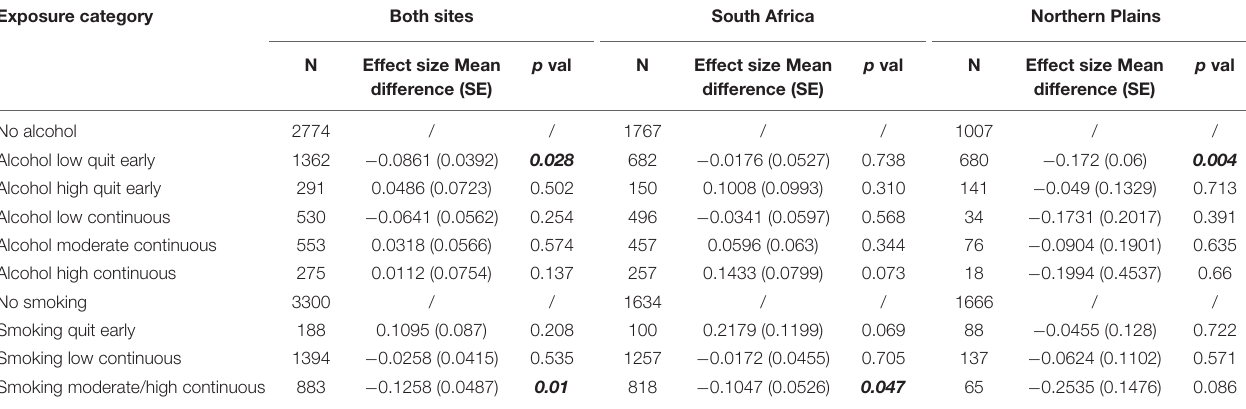
TABLE 10 | Linear regression results from alcohol and smoking exposure predicting mean fetal movement in 2F. Exposure category